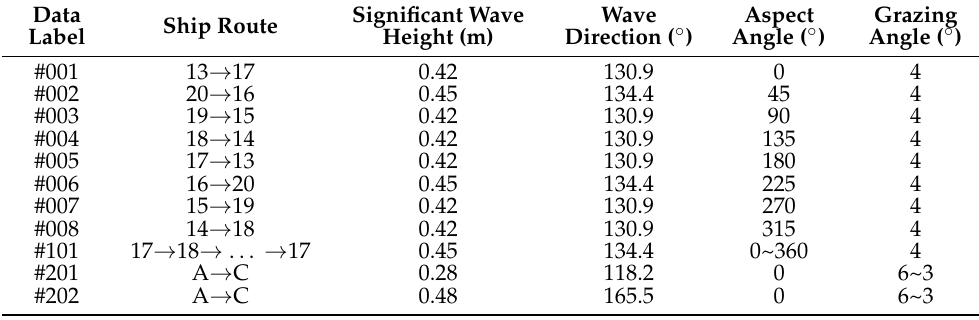
Table 2. Description of experimental data.